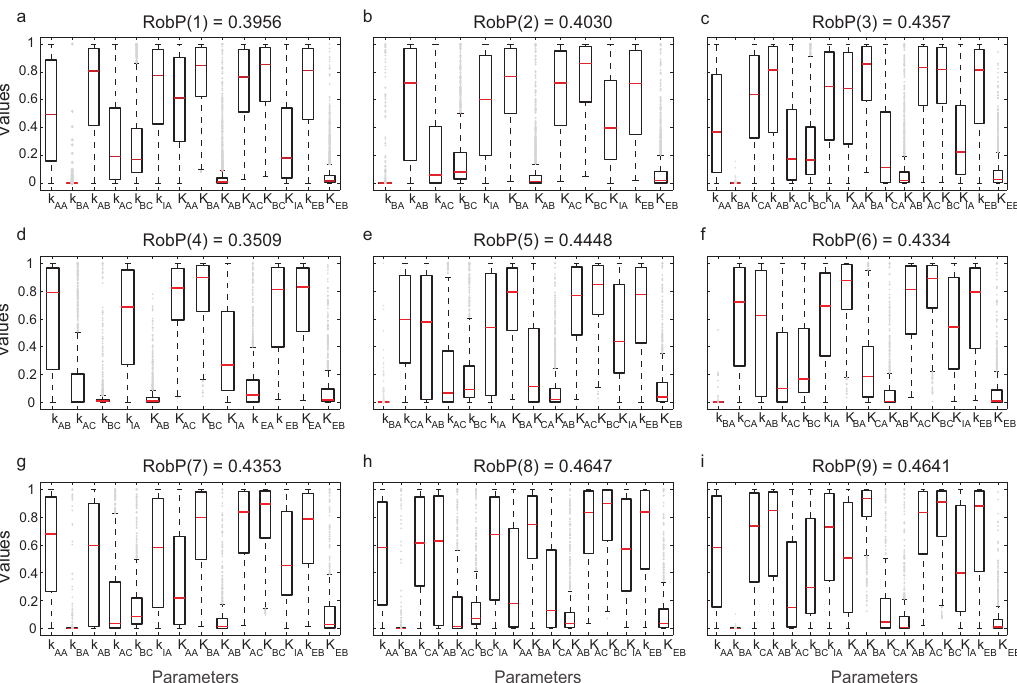
Figure 6. IQRs and RobP for each of the nine most frequent structures.